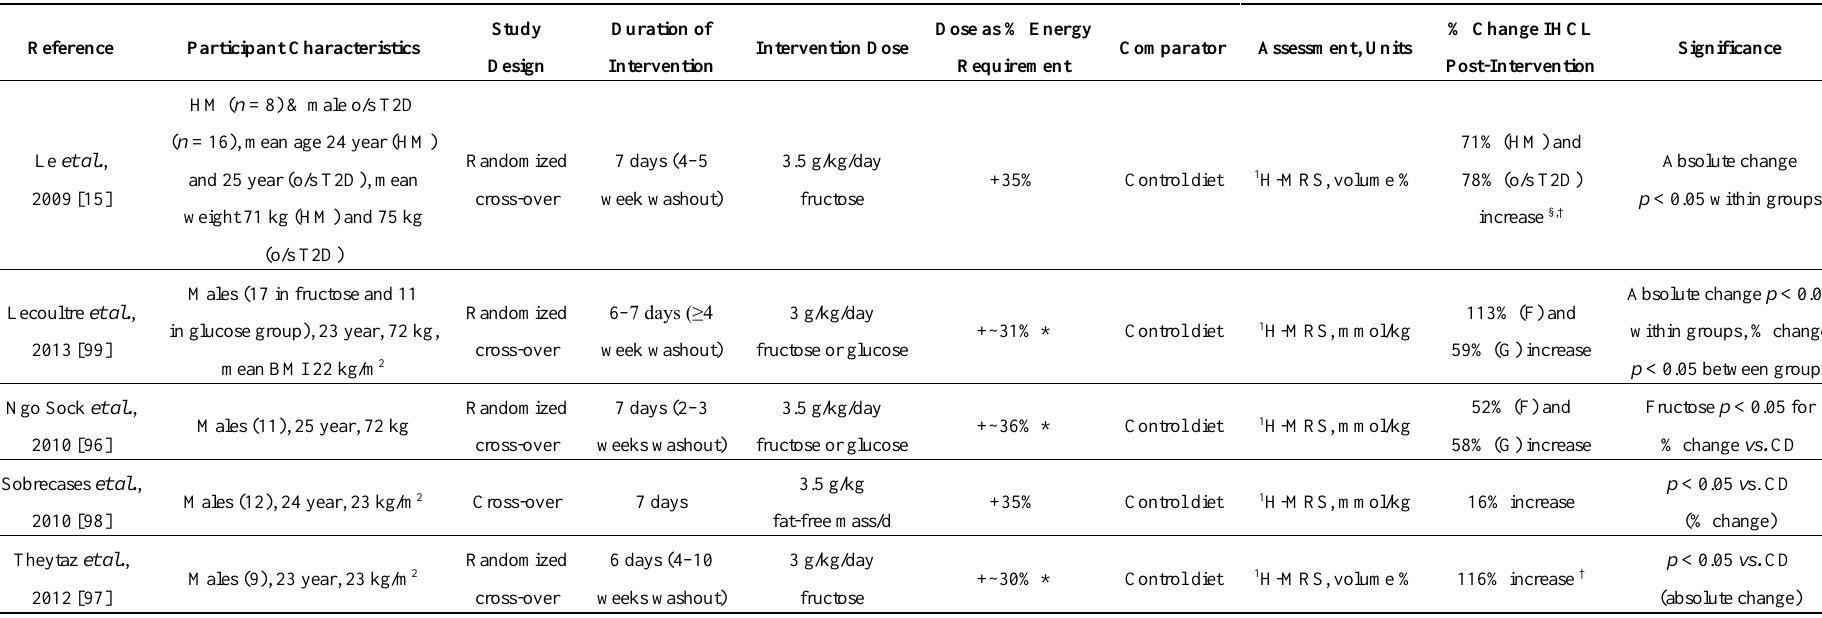
Table 1. Summary of study characteristics of short-term (≤7 days) monosaccharide feeding trials and IHCL